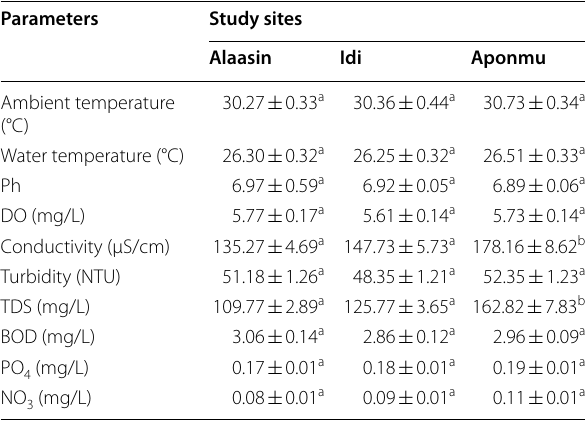
Table 3 Mean and standard error of the physicochemical parameters of three sites in